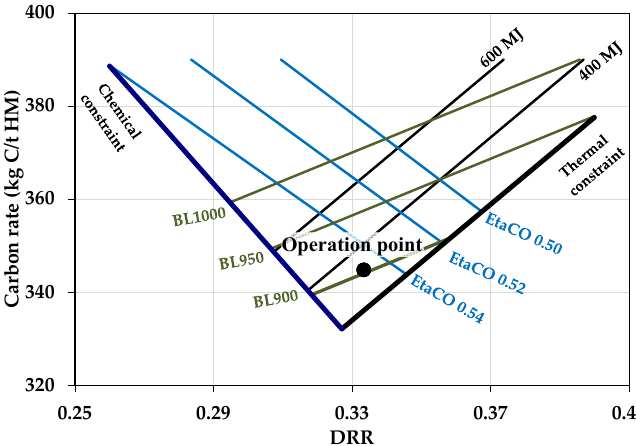
Figure 3. Carbon direct reduction rate (CDRR) diagram from MASMOD.